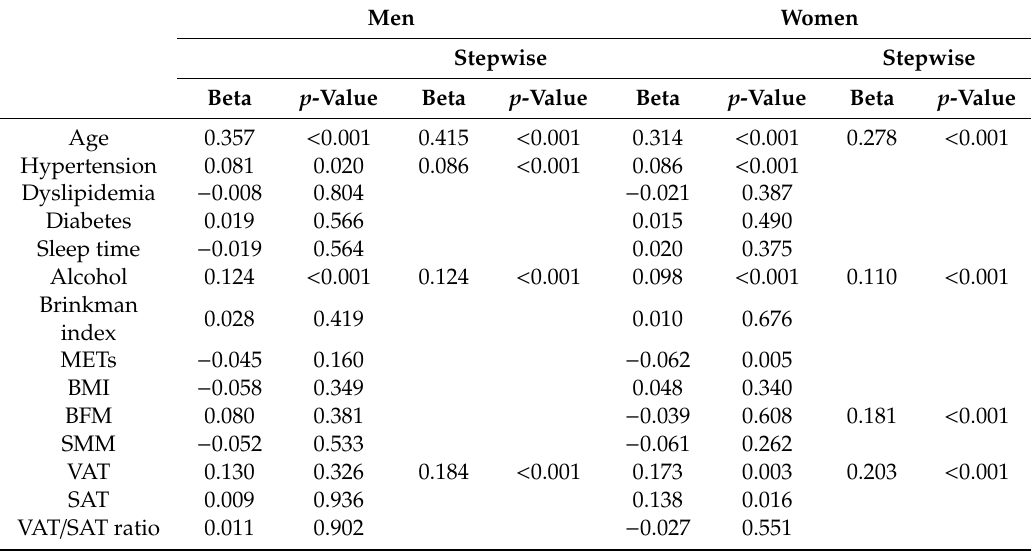
Table 3. Comparison of the association of MR-proADM with anthropometric